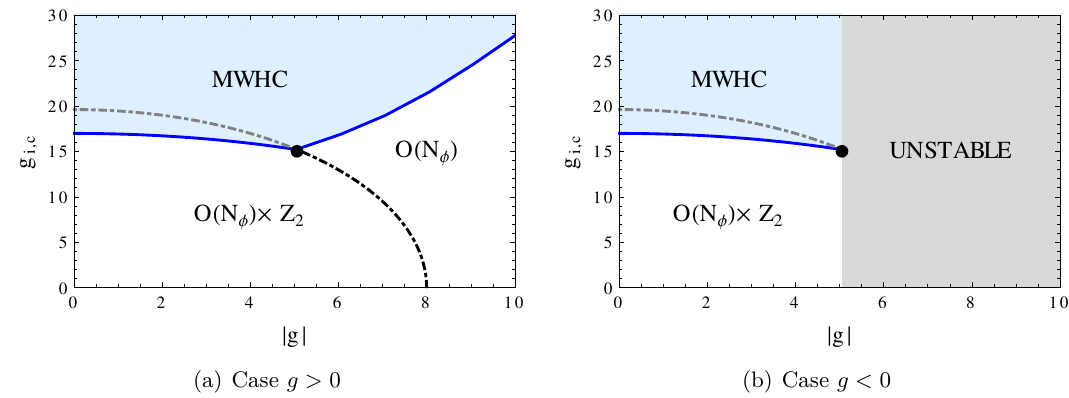
Figure 2 . Phase diagrams on the ( g i,c , g ) plane for g > 0 (panel a) and g < 0 (panel b). The continuous line represents g φ,c and the dash-dotted line represents g χ,c . In both panels the region labelled MWHC indicates where the O ( N φ ) symmetry is broken and thus excluded by the no-go theorem. Within the region labelled UNSTABLE in the right panel the boundness condition that applies to the case g < 0 is not observed. We have taken in this example N φ = 2 , which gives p g ∗ = 8 2 / 5 ’ 5 . 05 .